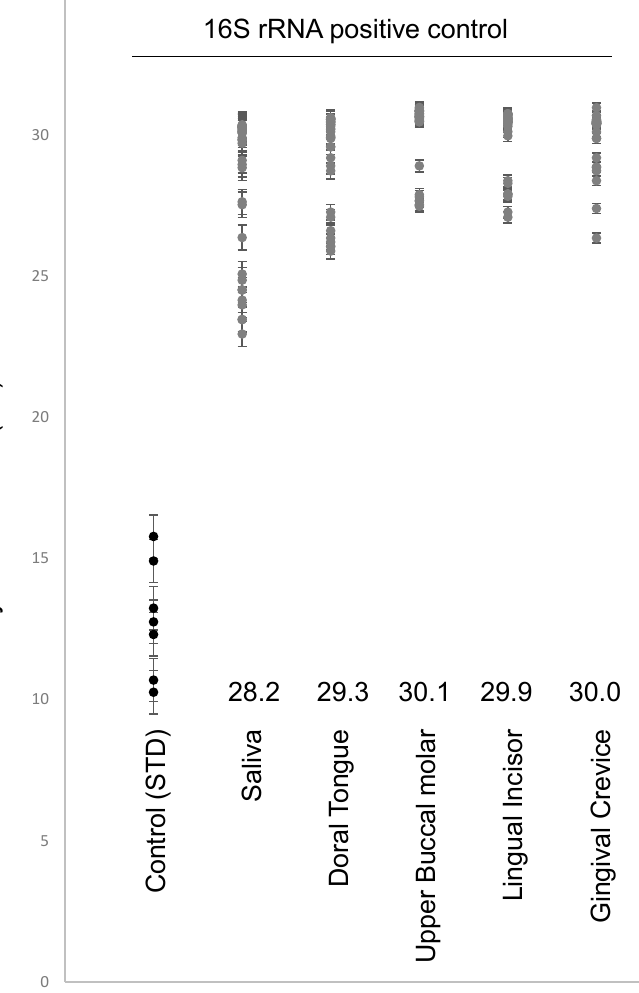
Figure 2. Real time qPCR screening of samples for 16S rRNA. Positive control standard 16S rRNA revealed all study samples harbored bacterial DNA with average cycle threshold (CT) counts ranging from 28.2 to 30.1, which were not significantly different from one another ( p = 0.513) but were higher than the positive control standards (10 ng/ μ L, 5 ng/ μ L, 2 ng/ μ L; CT average =12.86) ( p = 0.00018). Screening for S. noxia (SN) using qPCR for all sites from each patient revealed a total of n = 62/235 sites or 26.3% harbored this organism (Figure 3). More specifically, the site most commonly associated with an SN-positive result was saliva either alone or in combination with one or more sites, n = 23/27 or 85.18% (Figure 3A). The second most commonly associated site with SN-positive results was GCF either alone or in combination with saliva or other sites, n = 14/27 or 51.5%. Positive results for the other sites either alone or in combination with saliva or GCF were similar among the tongue (33.3%), lower lingual incisor (29.6%), and upper buccal molar (25.9%) (Figure 3B). Logistic regression of each site as a predictor of positive outcome for other sites revealed a strong odds ratio (OR = 17.8) between saliva and GCF, which was more significant than associations between any other combinations of sites ( p =